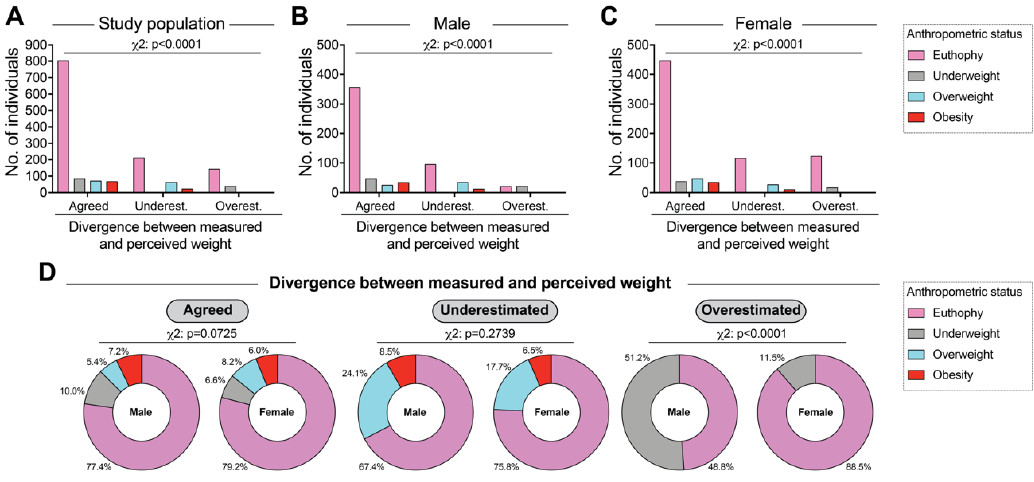
Figure 1. Frequency distribution of divergence between measured and perceived weight, stratified by anthropometric status and sex. ( A ) in all the study participants. ( B ) Male sex. ( C ) Female sex. ( D ) Frequency of different anthropometric status strata in study participants grouped according to divergence between measured and perceived weight. Data were compared using the Pearson’s chi–square test.